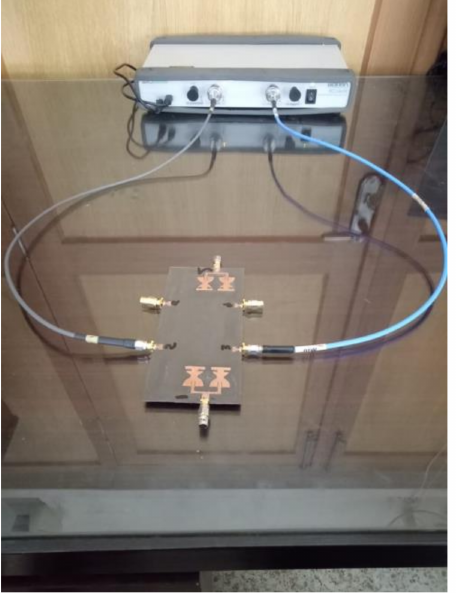
Figure 11. S-parameter measurement hardware